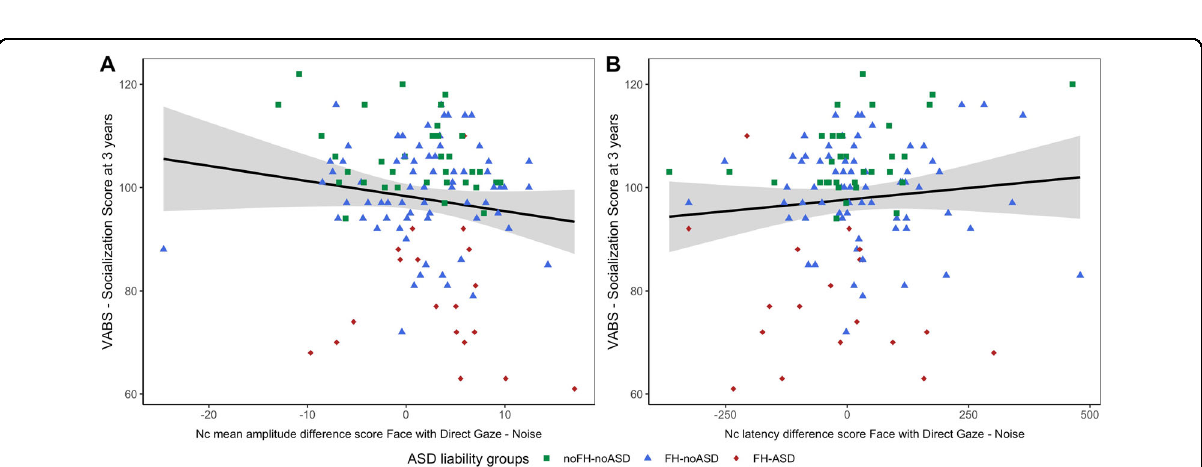
Fig. 4 Relationship between Nc features and later dimensional variation in social adaptive skills. Mean amplitude ( A ) and peak latency B difference between face with direct gaze and Noise at 8 months, on the x-